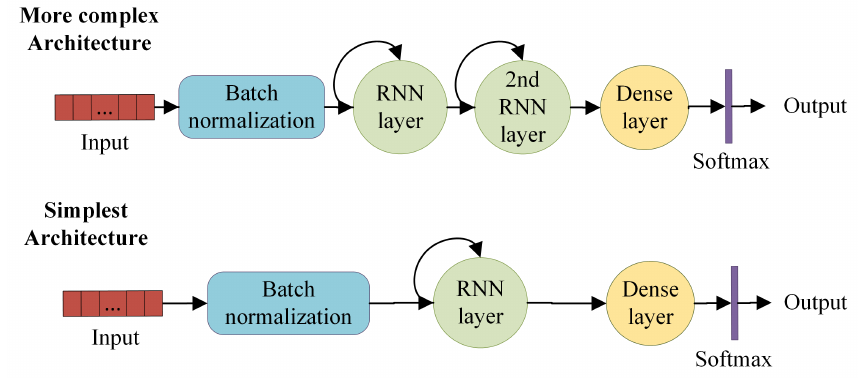
Figure 2. Diagram of the four recurrent neural network (RNN) architectures analyzed in this